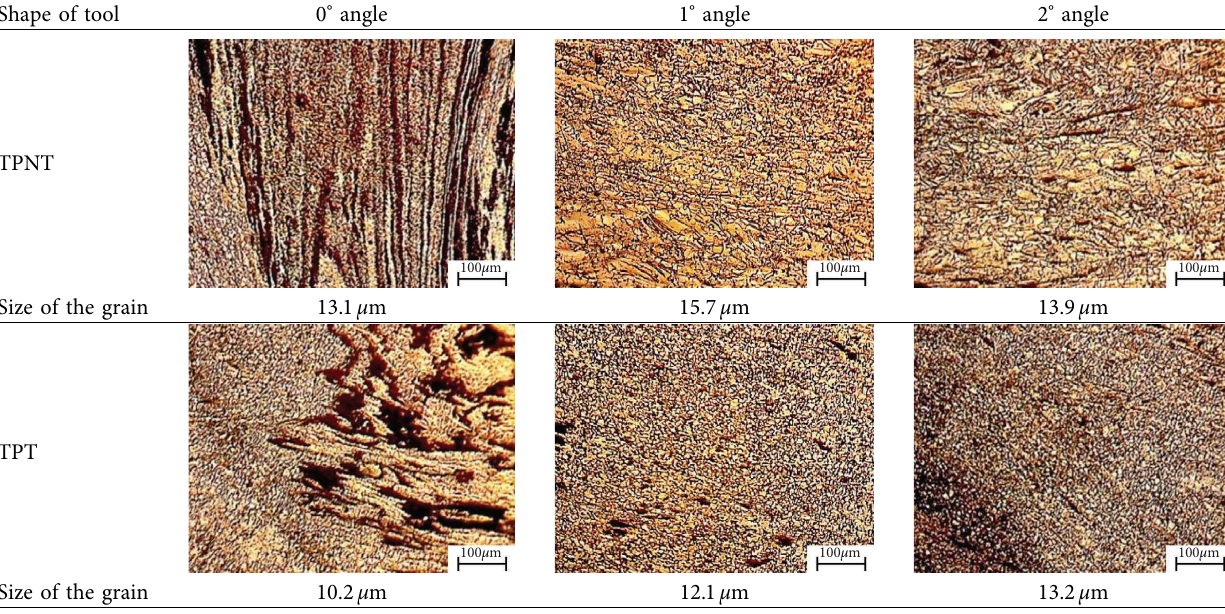
Table 2: Grain size in the nugget